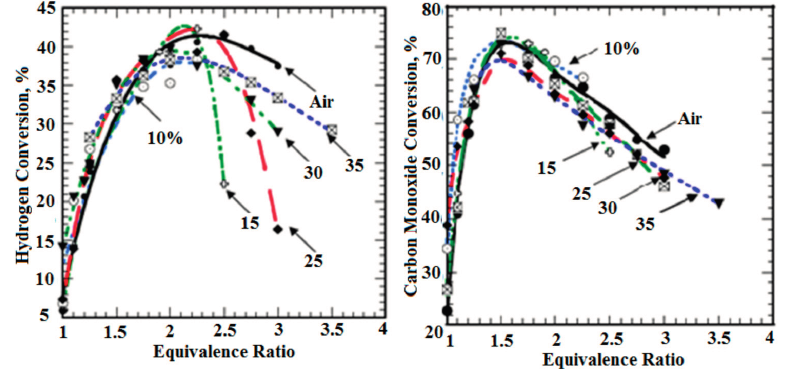
Figure 13. Hydrogen and CO conversion against equivalence ratio, for varying oxygen indices